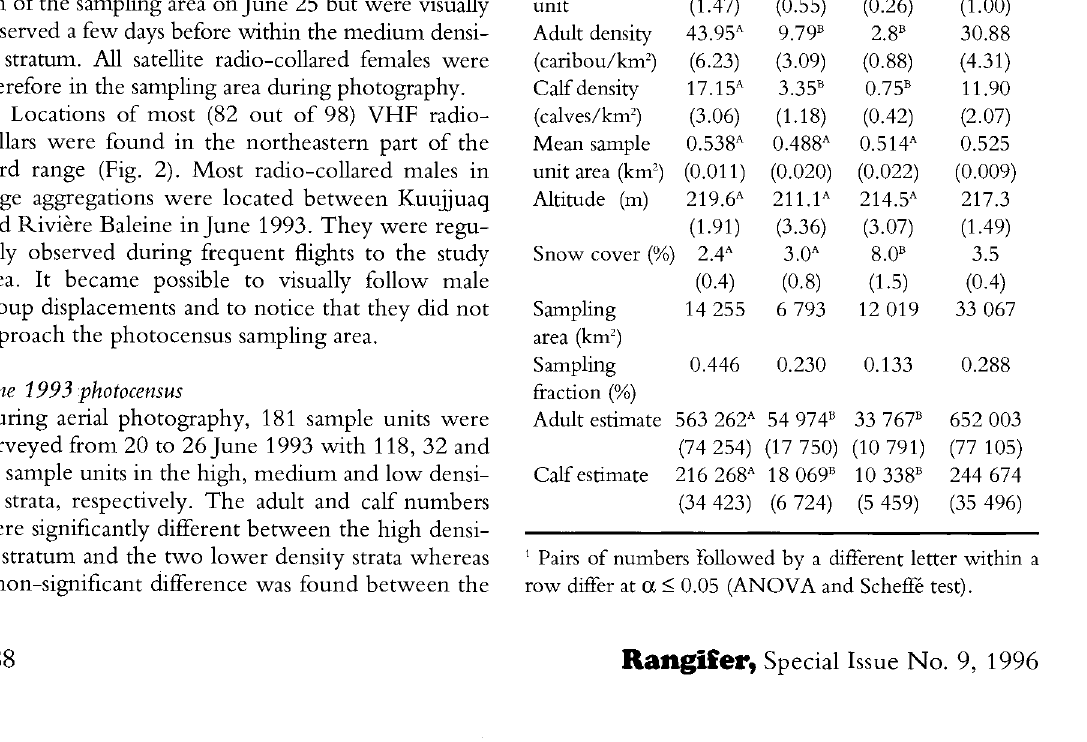
Fig. 2. Stratification pattern, locations of most VHF and satellite radio-collared caribou (8-10 June 1993, includes some locations that were made from 6-7 June and from 15-24 June 1993) and composition sampling locations (19-25 June